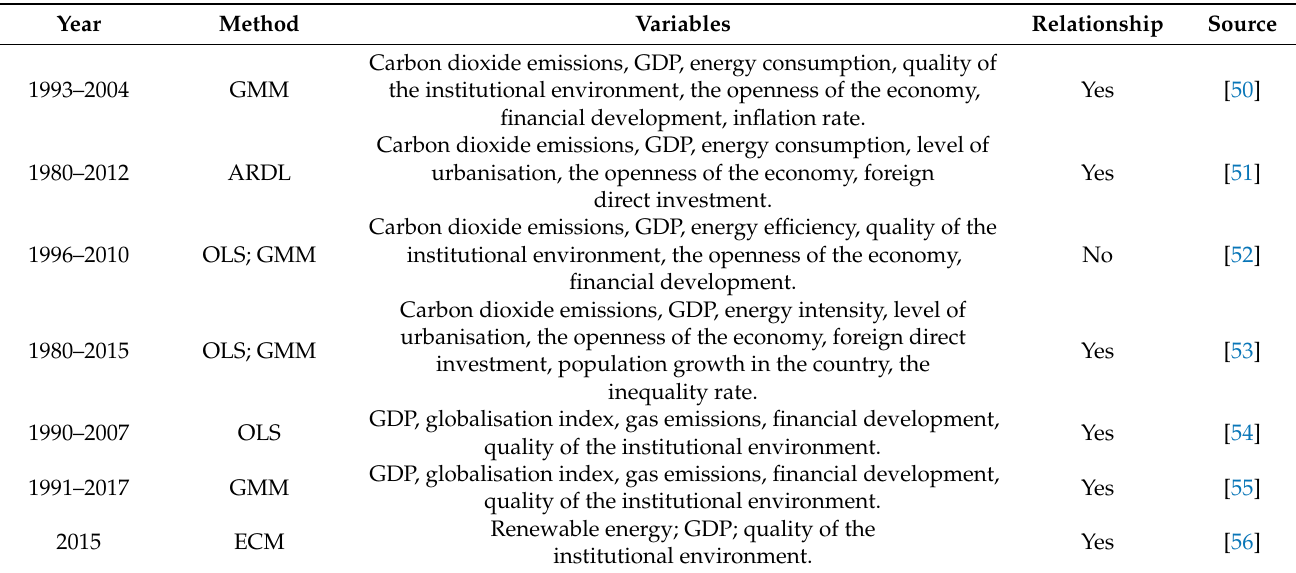
Table 1. Approaches to testing the hypothesis of the link among institutional environment, efficiency of economic, social, and ecological development, the dynamic of energy consumption from renewable energy, and the energy efficiency of the national economy (source: compiled by the